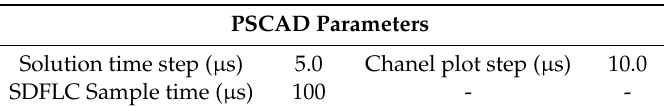
Table 1. PSCAD parameters.